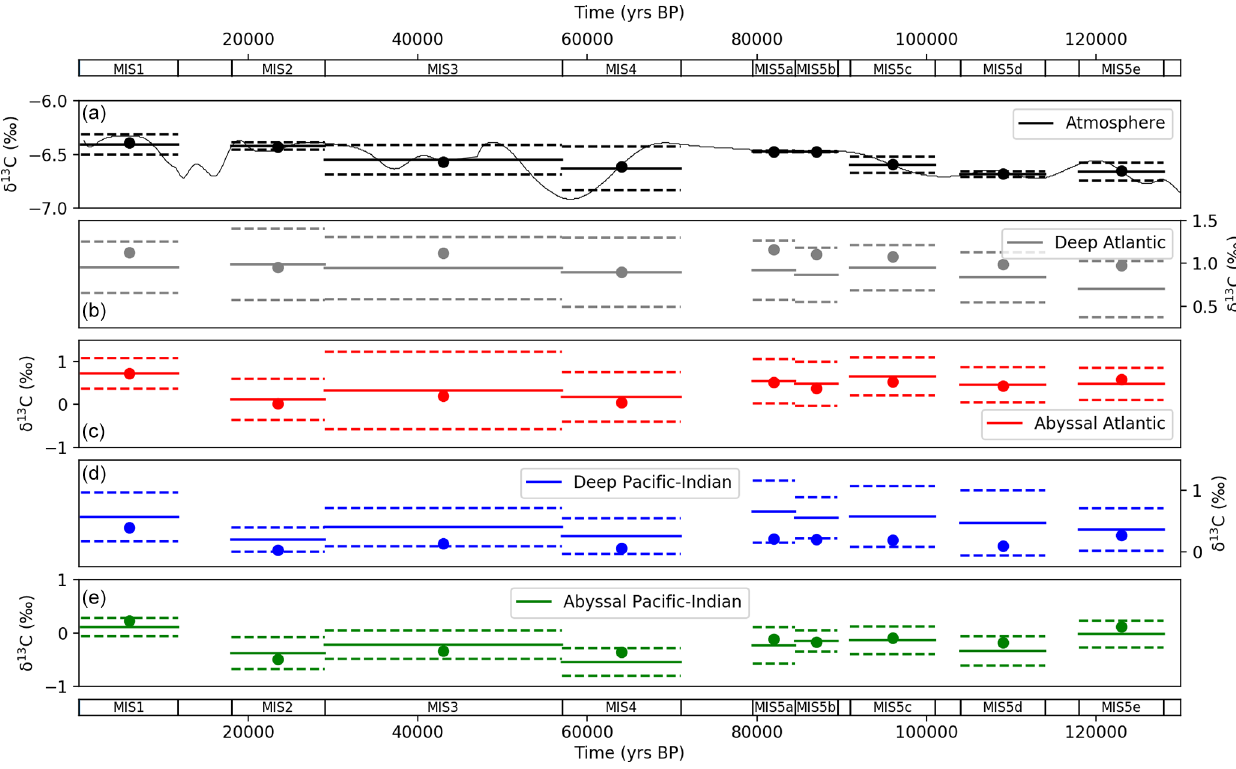
Figure 10. Values returned from the model–data experiment for δ 13 C for (a) atmosphere, (b) deep Atlantic (2500m average depth), (c) abyssal Atlantic (3700m average depth), (d) deep Pacific–Indian (2500m average depth) and (e) abyssal Pacific–Indian (4000m av- erage depth). Model–data experiment results are shown as dots, with proxy data mean (solid lines) and 1 standard deviation (dashed lines) in each MIS. Model results for each box in each MIS are shown in Tables S10 and